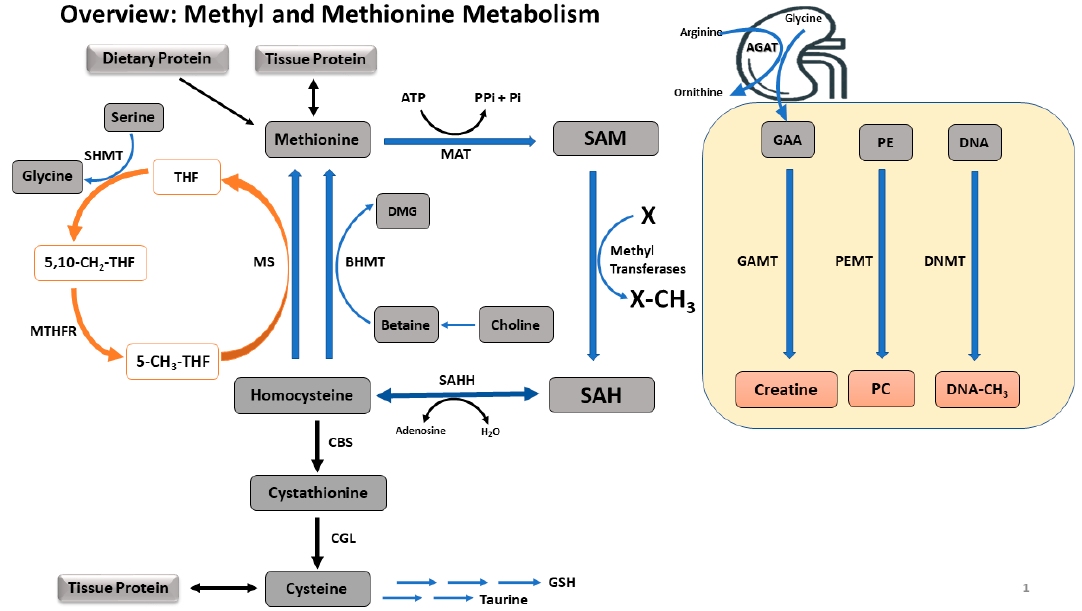
Figure 1. A summary of methyl and methionine metabolism. Methionine is an ubiquitous amino acid